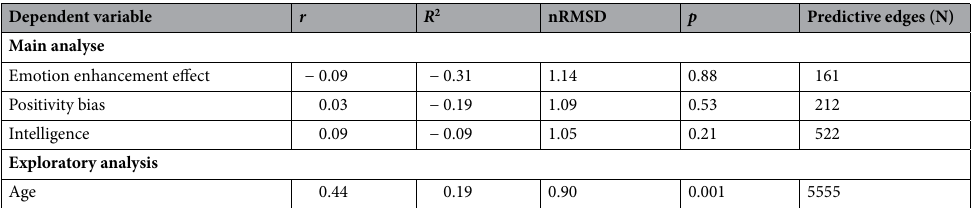
Table 3. Model prediction results when including participants across all age groups (18–87 years old). For all variables, we used Elastic Net, with ridge-lasso ratio = 0.01. The models were trained using leave-one-out cross-validation. p -values were calculated as the number of permutations with lower R 2 divided by 1000. The emotion enhancement effect refers to the degree to which neutral objects were learned better when they were paired with emotional rather than neutral background images. The positivity bias represents the degree to which objects paired with positive backgrounds were remembered better than those paired with negative backgrounds. The number of predictive edges represents the average number of edges that were included after filtering and regularisation across all folds.